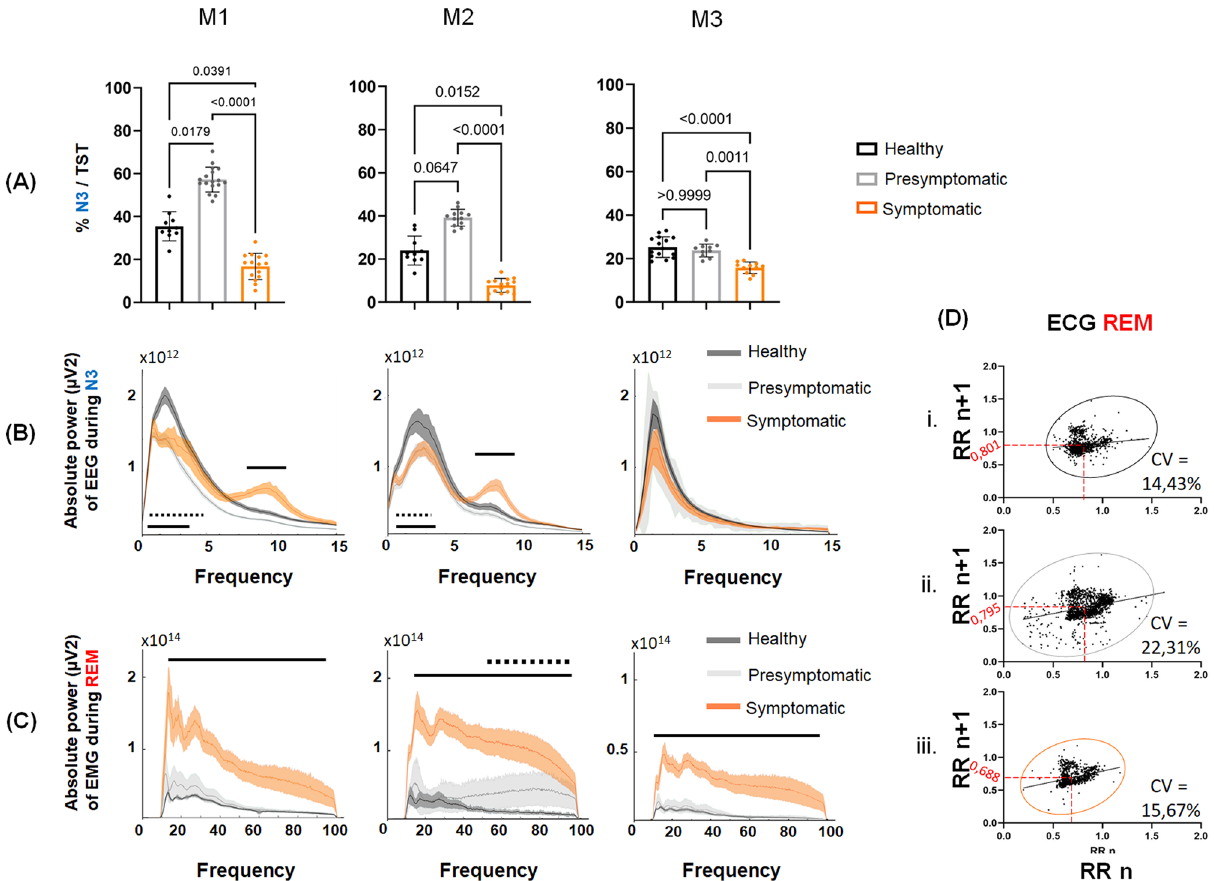
Figure 3. Nighttime sleep micro-architecture. ( A ) Nighttime non-REM sleep N3 quantity, for M1, M2 and M3, during healthy (black), presymptomatic (light grey) and symptomatic (orange) states, expressed as % of N3 on the TST. ( B ) Mean ± 95% confidence interval of absolute power depending on frequency of EEG during nighttime N3 for M1, M2 and M3, during healthy (dark grey), presymptomatic (light grey) and symptomatic (orange) states. ( C ) Mean ± 95% confidence interval of absolute power depending on frequency of EMG during nighttime REM sleep for M1, M2 and M3, during healthy (dark grey), presymptomatic (light grey) and symptomatic (orange) states. For ( B ) and ( C ), the dashed black line indicates significant differences between healthy and presymptomatic states and the solid black line indicates significant differences between healthy and symptomatic (one-way ANOVA; p < 0.05). ( D ) Poincare plots build from successive RR intervals (x-axis: RR n and y-axis RR n + 1) expressed in second during REM sleep during the healthy (i), presymptomatic (ii) and symptomatic (iii) states. The red number correspond to the meanNN interval and CV correspond to the coefficient of